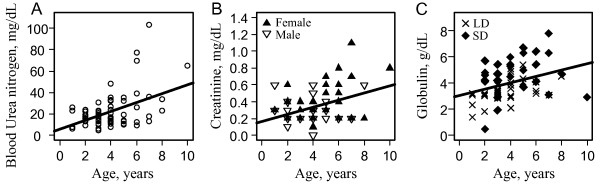
Statistical analyses were performed utilizing a Pearson correlation. (A) Simple linear regression between blood urea nitrogen levels and age (n=77, r=0.46, p<0.001). (B) Simple linear regression between creatinine levels and age (n=75, r=0.28, p<0.01). (C) Simple linear regression between total blood globulin concentration and age (n=73, r=0.20, p<0.05), LD: long-day season; SD: short-day season.